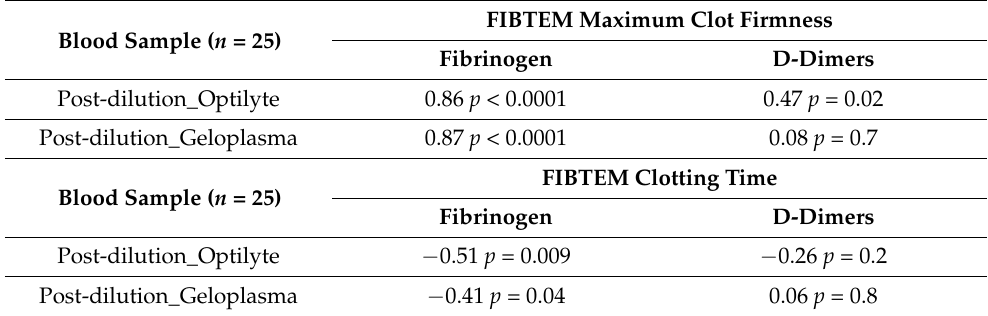
Table 6. Correlations between FIBTEM parameters and standard laboratory tests 1